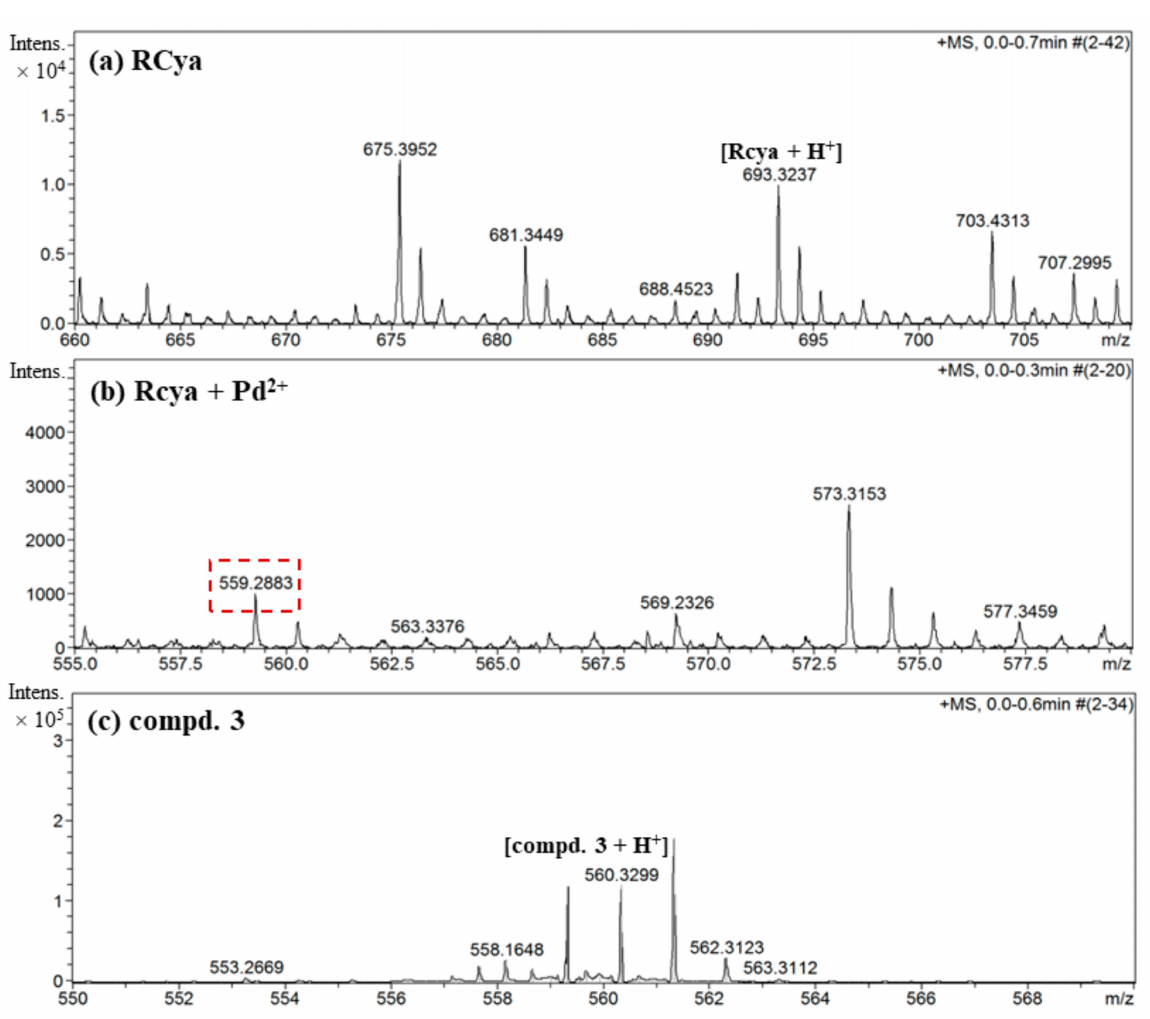
Figure 8. HRMS analysis on the recognition process of probe RCya to Pd 2+ .